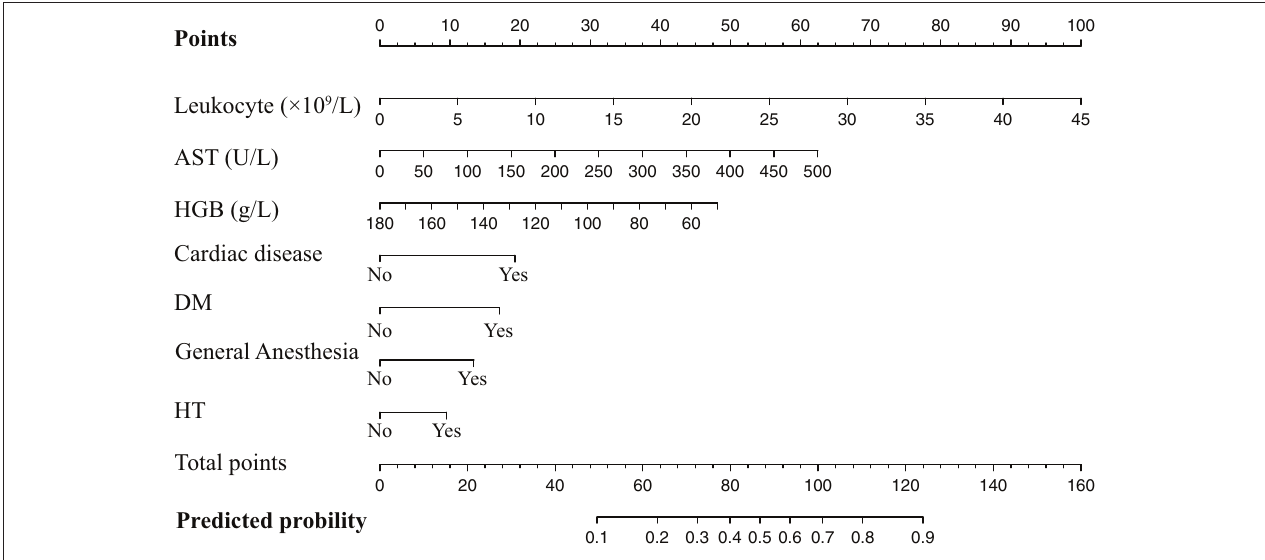
FIGURE 2 | Nomogram of the training set used to predict the MACEs risk. AST, aspartate aminotransferase; HGB, hemoglobin; DM, diabetes mellitus; HT, hypertension.